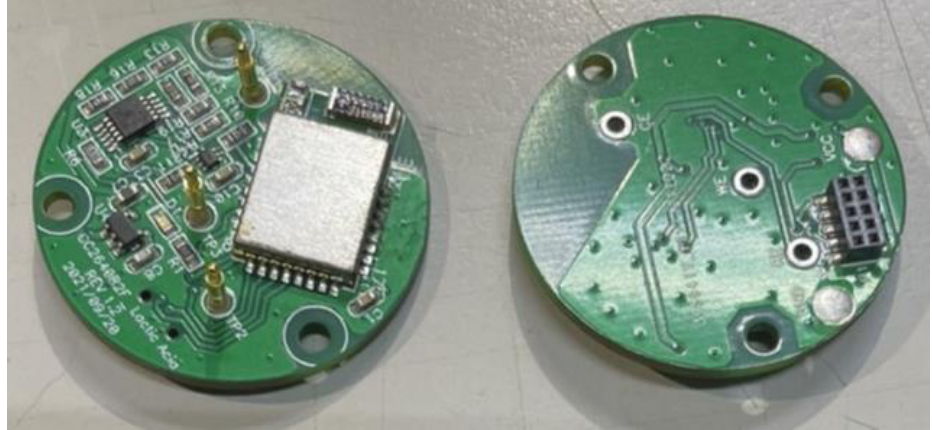
Figure 10. Front and back of the circuit of the MAX9913 operational amplifier.